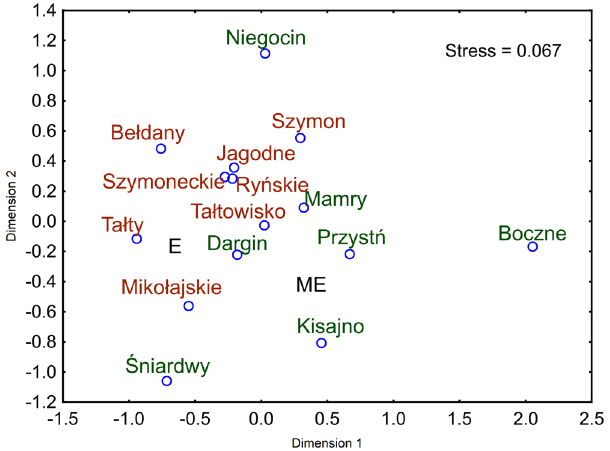
Figure 5. Bray-Curtis-based NMDS analysis of the relative respiration of 31 different carbon sources by bacteria in the studied lakes. The lakes marked in red are eutrophic (E), and lakes marked in green are meso- eutrophic